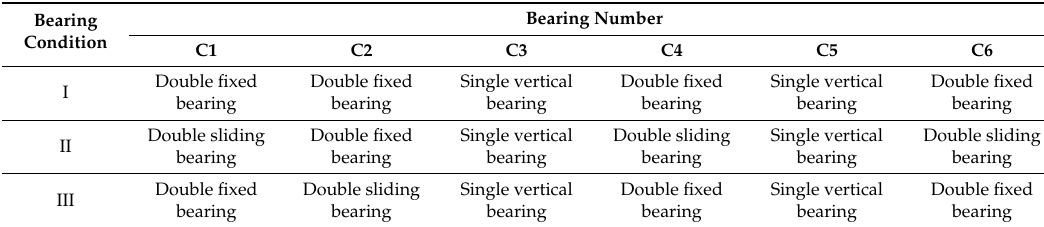
Table 4. Bearing conditions of the irregularly-shaped bridge.